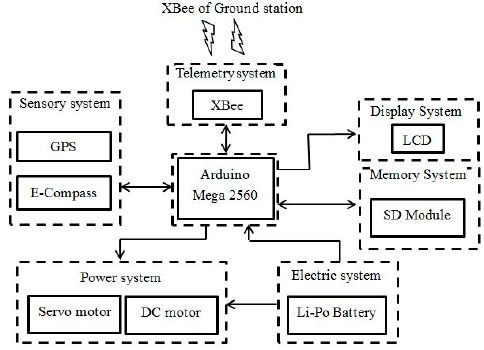
Figure 4. Architecture diagram of the sub-system of a robot car.